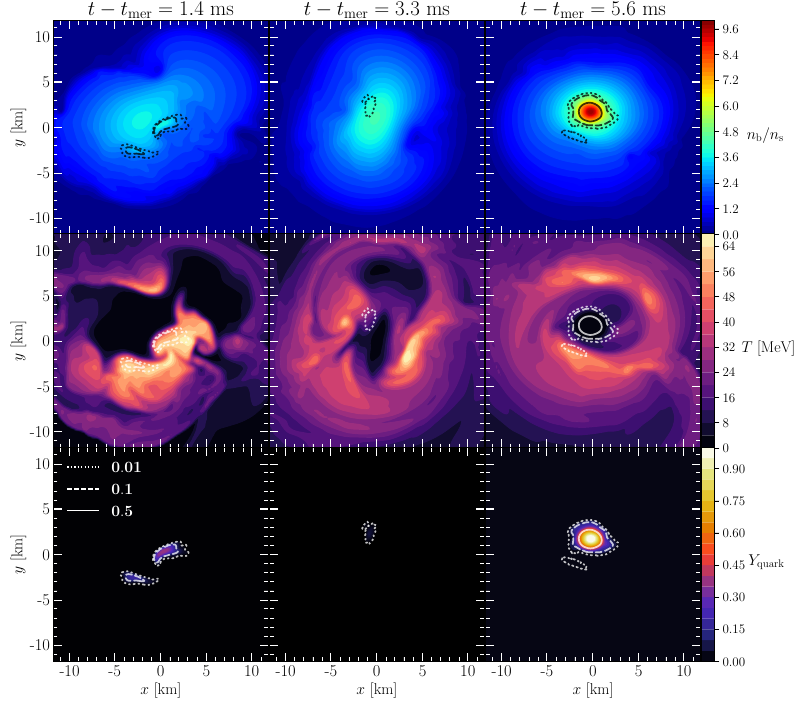
Figure 3: From top to bottom rows we show snapshots of the baryon-number den- sity, temperature and quark fraction in the orbital plane at three different times = 1.4, 3.3, 5.6 ms (from left to right) that are representative for HQ, WQ t − t mer and CQ stages in the Soft_q07 simulation. In addition we mark contours for the = 0.01, 0.1, 0.5 by dotted, dashed and solid lines, quark fraction Y quark